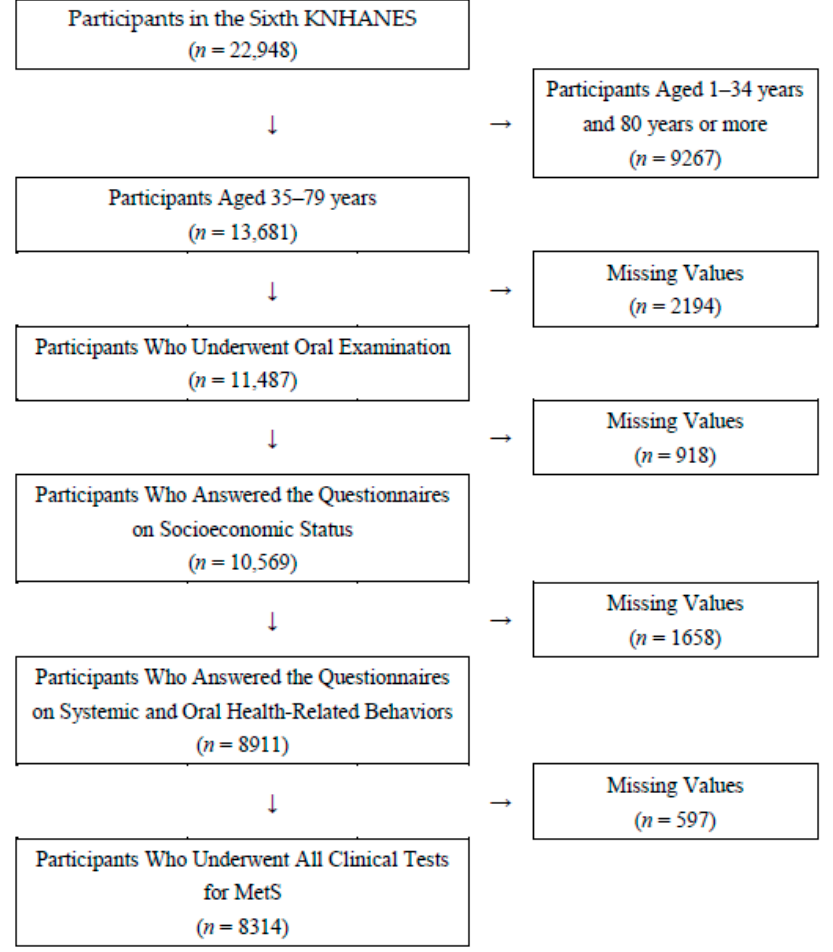
Figure 1. Flow chart for sampling of study participants. MetS: metabolic syndrome.